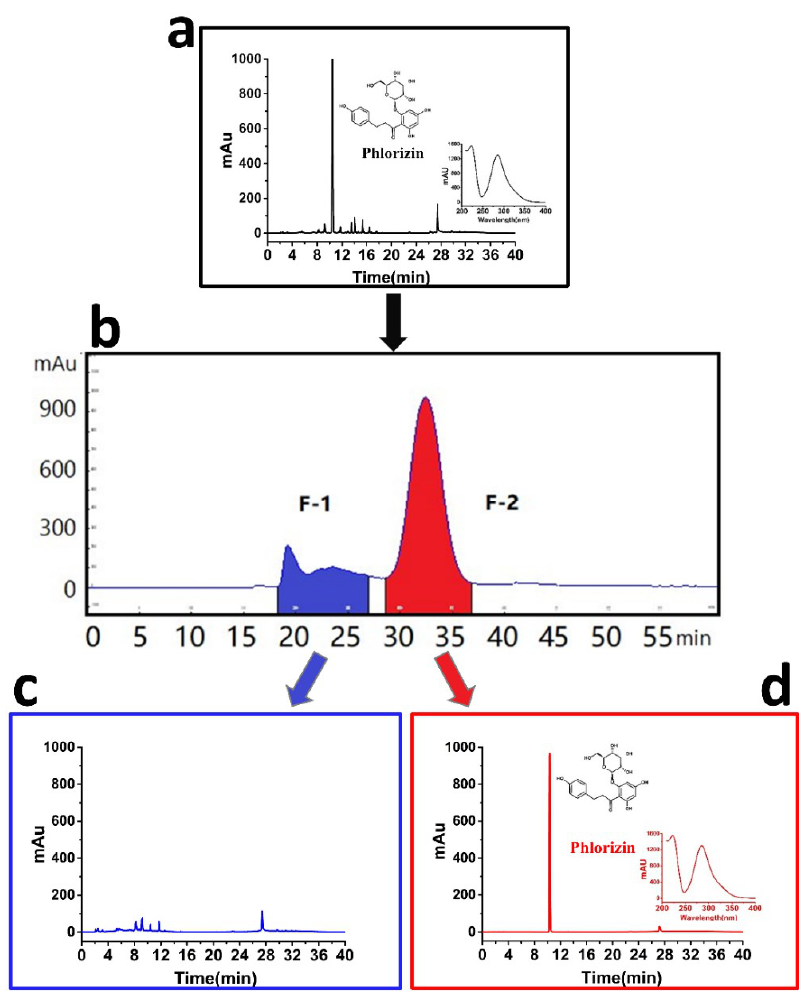
Figure 1. High-speed counter-current chromatography (HSCCC) and HPLC chromatogram. ( a ) HPLC chromatograms of Decne extract (DIDE), ( b ) HSCCC chromatograms of DIDE, ( c ) HSCCC peak fraction 1, ( d ) HSCCC peak fraction 2.